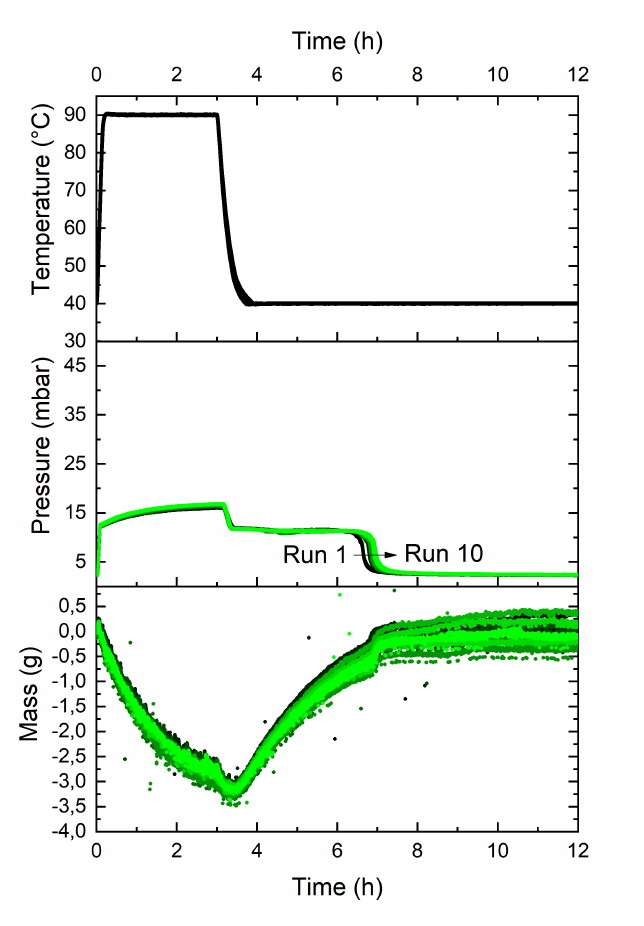
Figure 5. The temperature, pressure and change in mass of a TCM with mass of vessel 2 initially filled with 21.5 mg hydrated K 2 CO 3 and vessel 1 with water during 10 cycles of dehydration/hydration. The peak at 0, 3 and 6 h in the change in mass curve is a result of the heater which is turned on and off as result of dehydration, hydration and stopped hydration. Each run has its own color whereby the color tranforms from black to green by increased run number. The data of this graph is re-used from J. Houben et al.